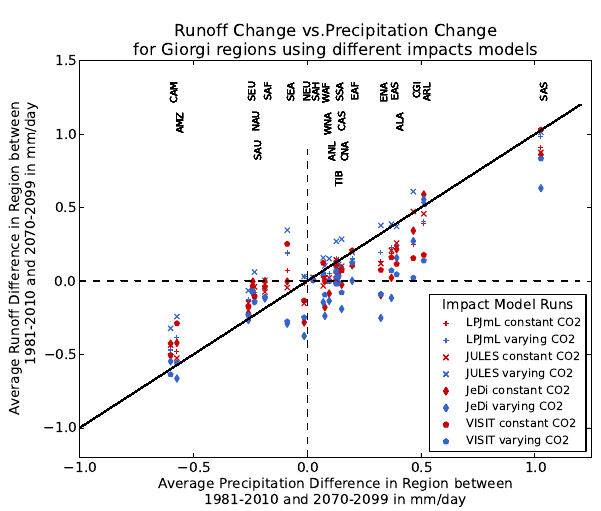
Fig. 5. Scatter plot of precipitation change against runoff change between 1981-2010 and 2070-2099 in mm day-1 for the Giorgi regions – for models including both varying and constant CO 2 forced with HadGEM2-ES RCP8.5 climate. Solid 1:1 line. Dashed x=0 line and y=0 line.